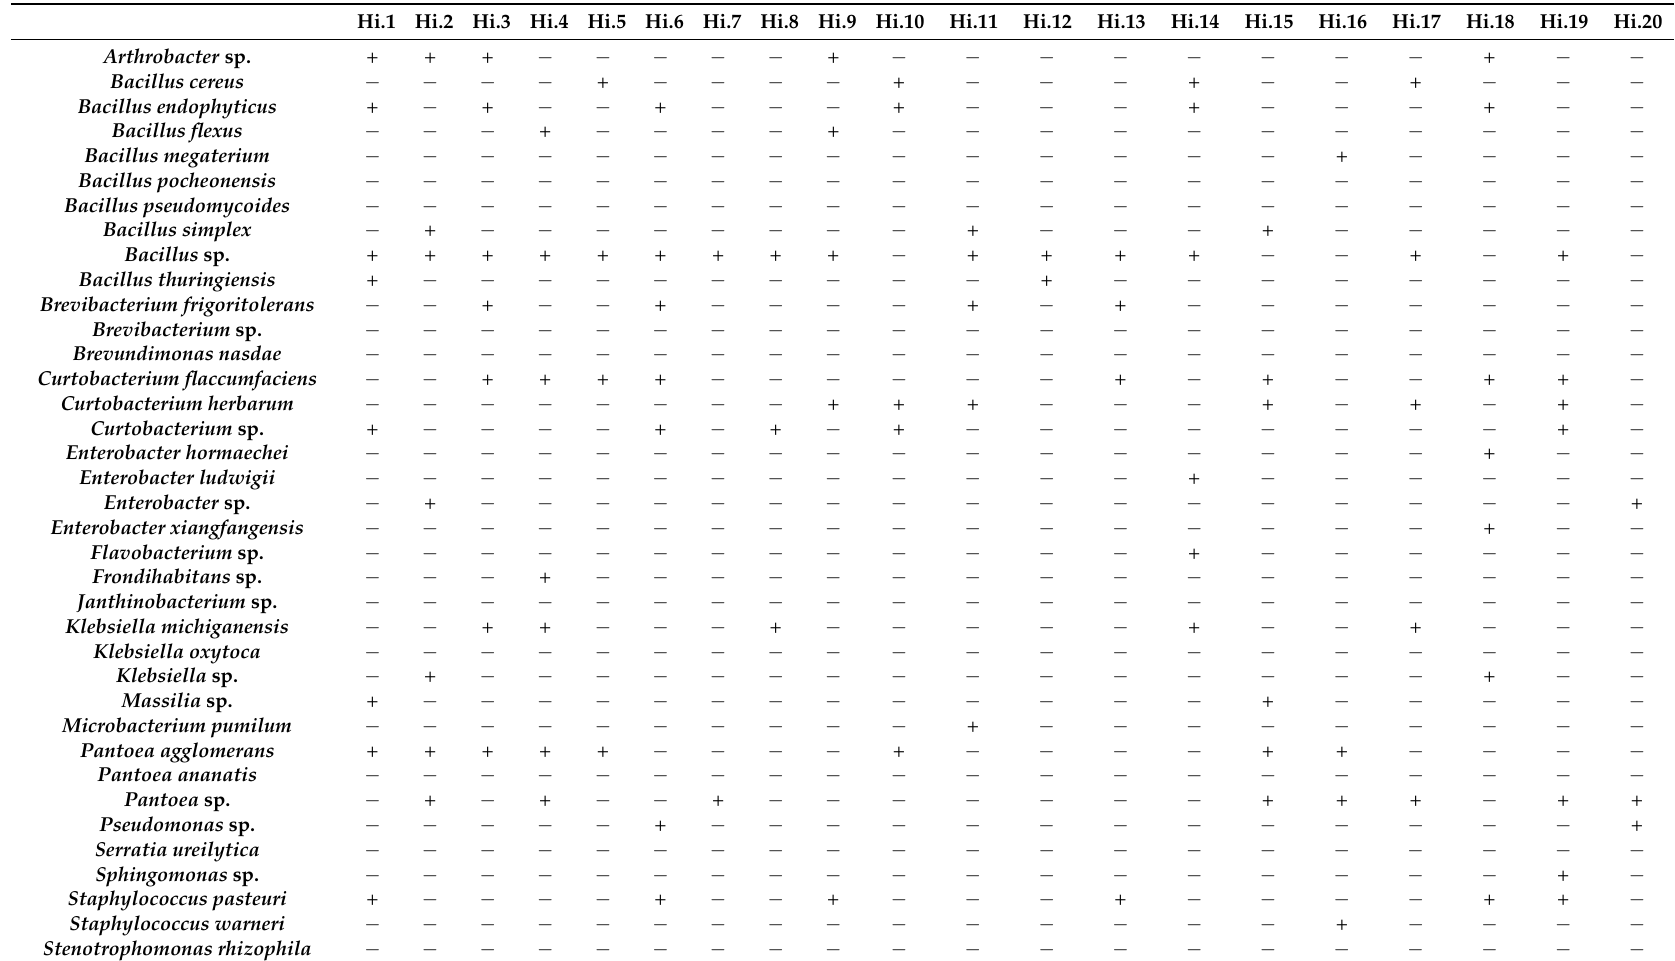
Table 3. Bacterial species isolated from Hippolais